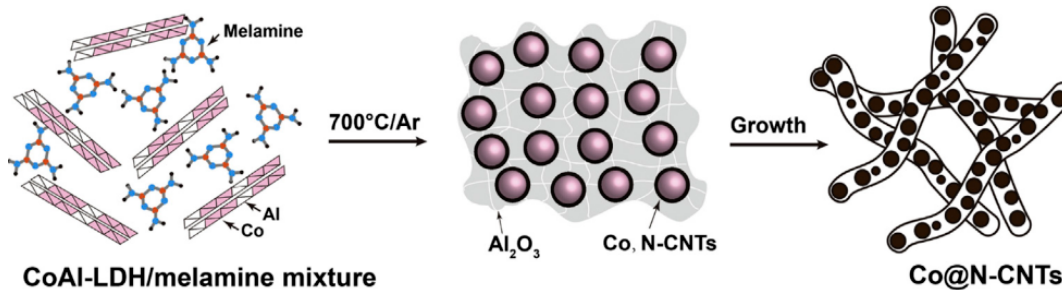
Figure 8. Representation of Co@N–CNTs–m resulting from CoAl–layered double hydroxides (LDH)/melamine mixture. Reproduced from [32], Copyright © Elsevier, 2016.